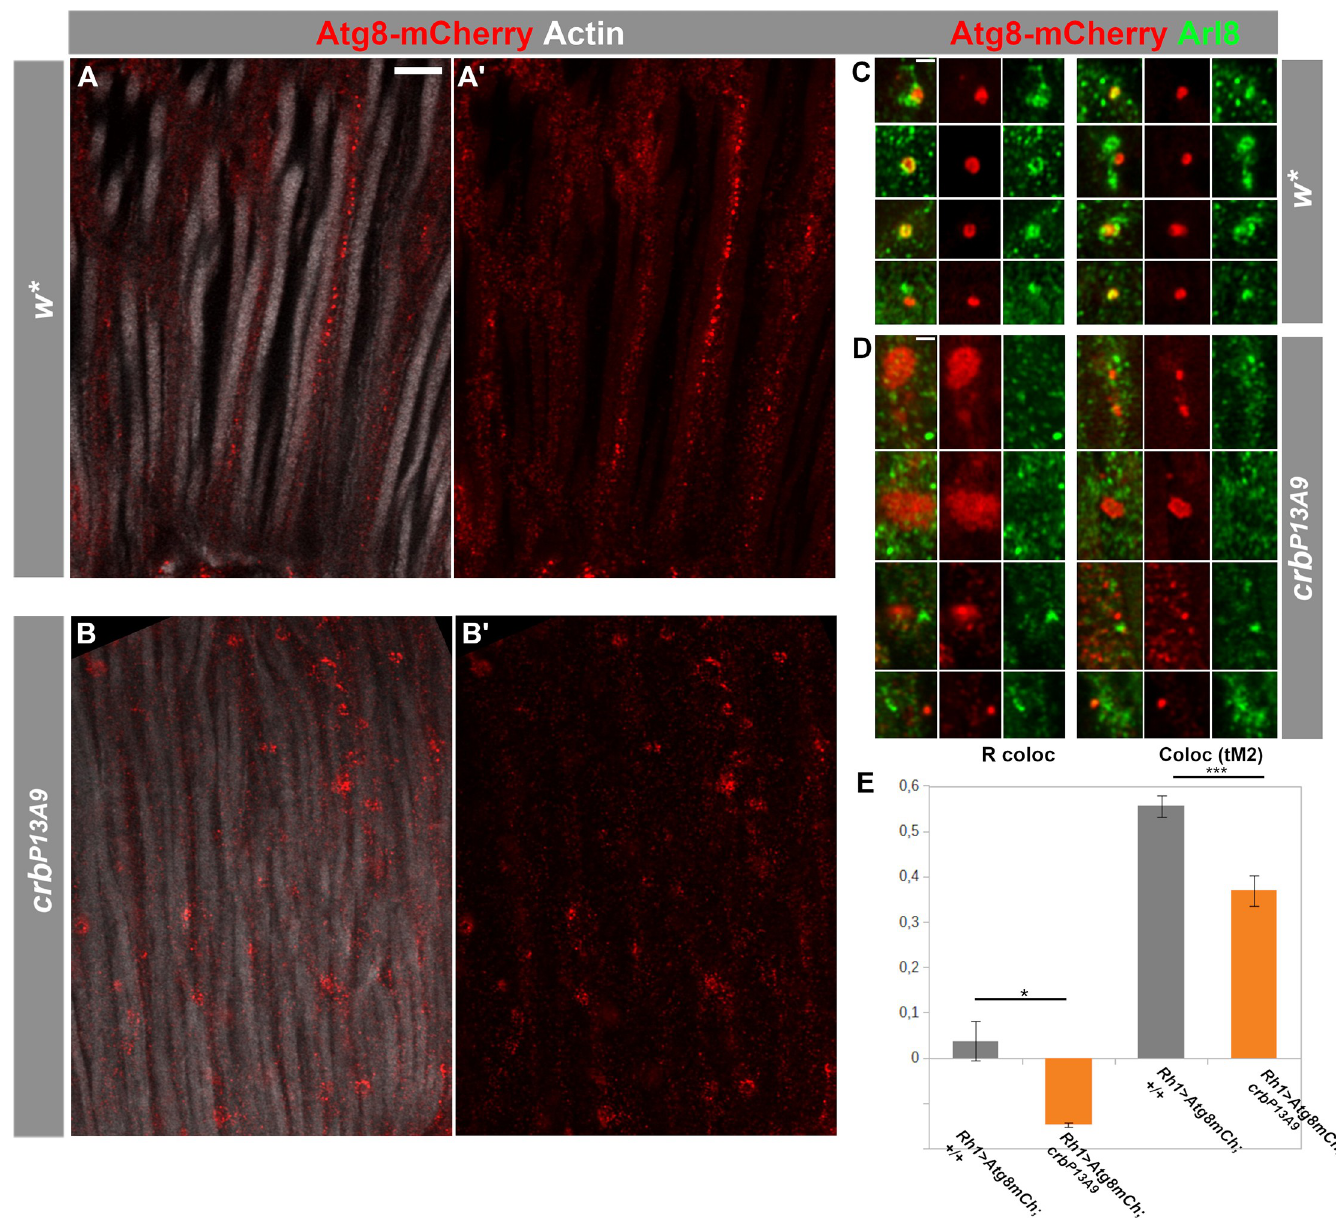
Fig 6. Autophago-lysosomal marker Atg8-mCherry loses its association with Arl8 in crb P13A9 mutant retinas. (A-B’) Longitudinal optical sections of w � ( A, A’ ) and crb P13A9 ( B, B’ ) retinas of flies expressing Rh1 -Gal4-mediated Atg8-mCherry (red). Retinas of flies kept for 6 days at 12h light/12h dark show differences in morphology of autophago-lysosomes in crb P13A9 ( B, B’ ). Rhabdomeres are labelled for F-actin (phalloidin; white). Scale bar: 5 μ m. (C, D) Examples of single autophagosomal Atg8-mCherry compartments (red) in w � ( C ) and crb P13A9 ( D ). Atg8-mCherry is often directly adjacent to or surrounded by Arl8 (green) in the control ( C ), whereas it is non-overlapping with Arl8 in crb P13A9 ( D ). Scale bars: 1 μ m. (E) Quantification showing loss of Atg8-mCherry (driven by Rh1-Gal4) co-localization with Arl8 in crb P13A9 in individual compartments, similar to those shown in C and D ) measured by Pearson’s R coloc and Manders’ thresholded co-localization coefficient tM2 for the Atg8-mCherry channel. Total compartment number (n) for w � = 26, n for crb P13A9 =